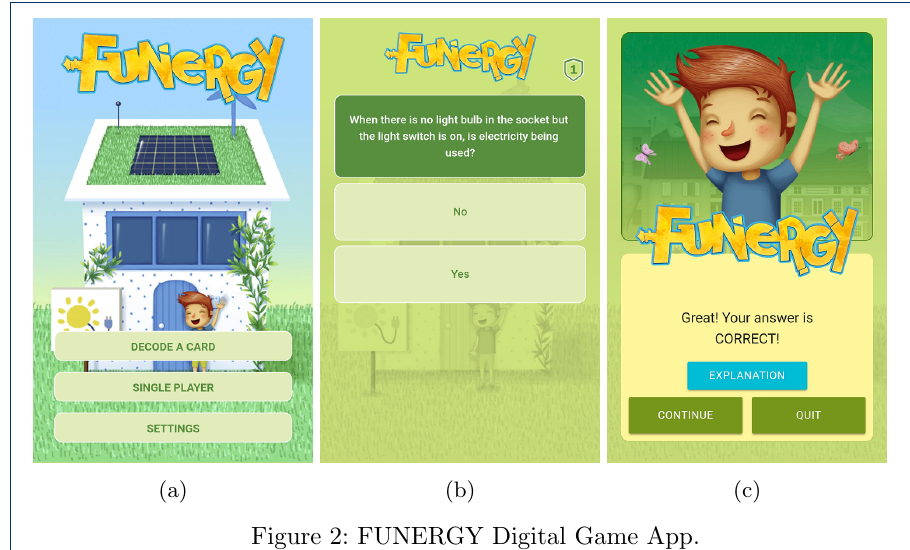
Figure 2: FUNERGY Digital Game